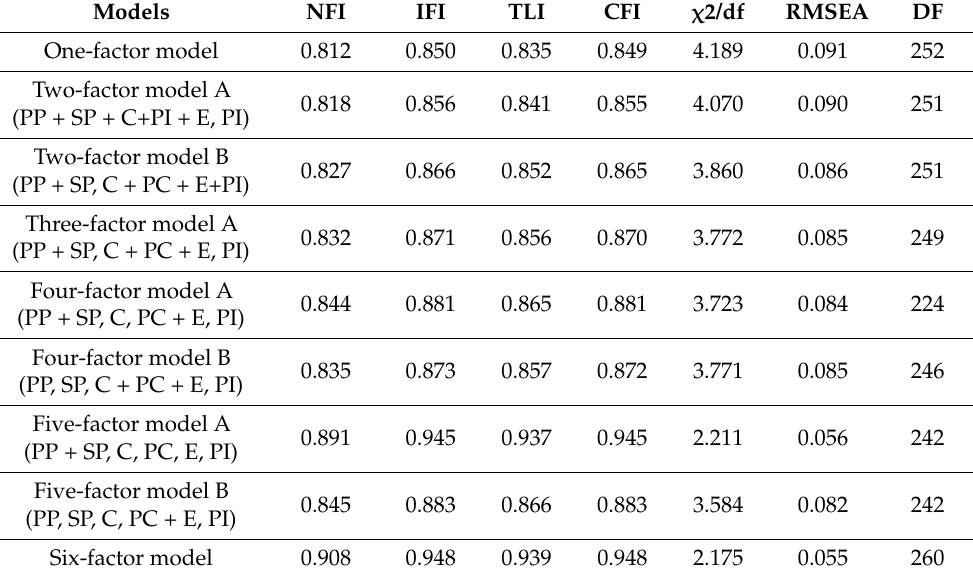
Table 4. Confirmatory factor analysis results.